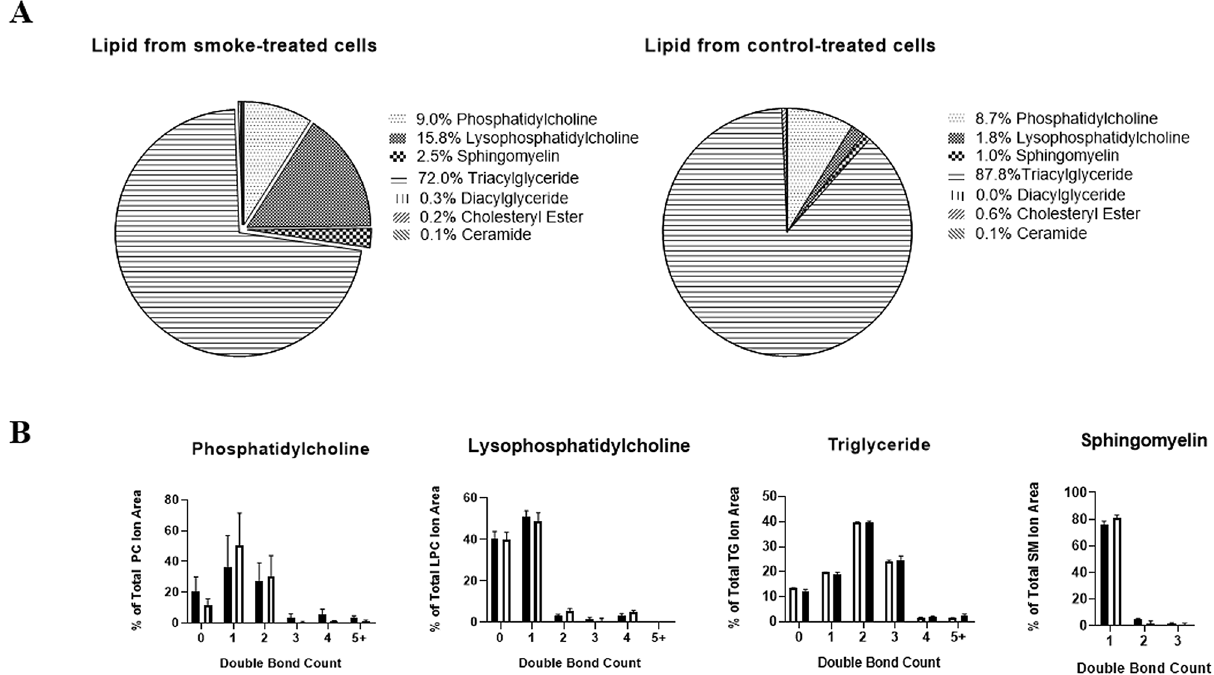
Figure 5. Lipid distribution by class and double bonds within major classes in 16HBE total cellular lipid. ( A ) Distribution of lipids from each class was obtained by finding the total ion area of each class from each sample, and the class signal as a proportion of the total ion area were obtained. Data represents an average of each treatment group to obtain a qualitative view of the class-based distribution between samples. N = 5 samples per treatment group ( B ) The proportion of lipids with a given number of double bonds across both acyl chains was obtained by finding the average percentage distribution of each double bond count in each sample. Data are presented as average per treatment group + SD. N = 5 samples per treatment group. Total lipid extracted from White = control or black = smoke exposed 16HBE